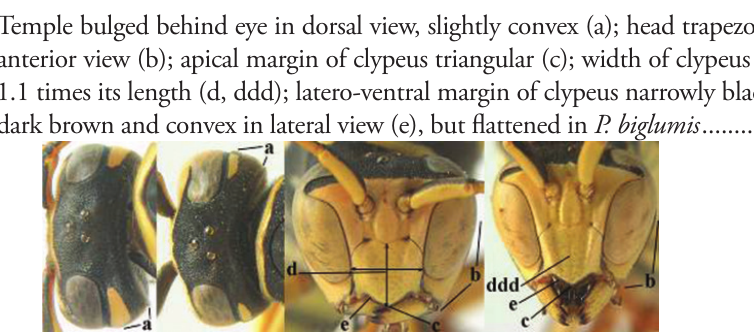
dark brown and convex in lateral view (e), but flattened in P. biglumis ........... 25